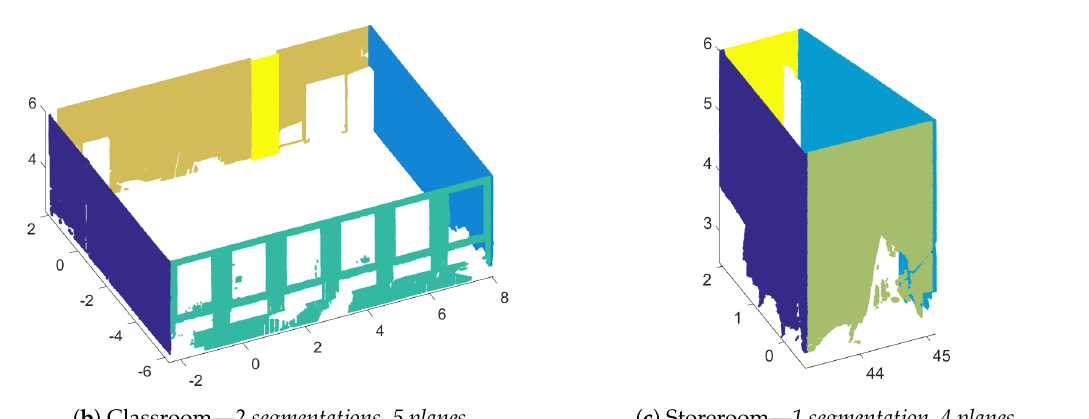
Figure 6. Plane segmentations of rooms (one colour per plane)— Number of segmentations determined automatically and number of extracted planes